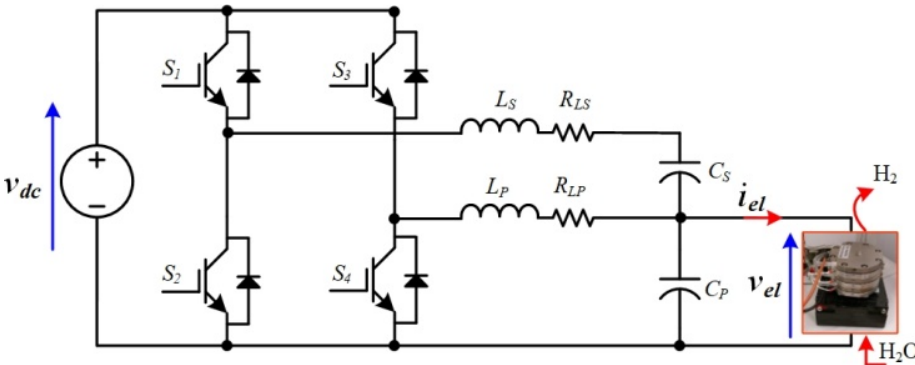
Figure 21. Stacked interleaved DC–DC buck converter connected to a PEMEL.